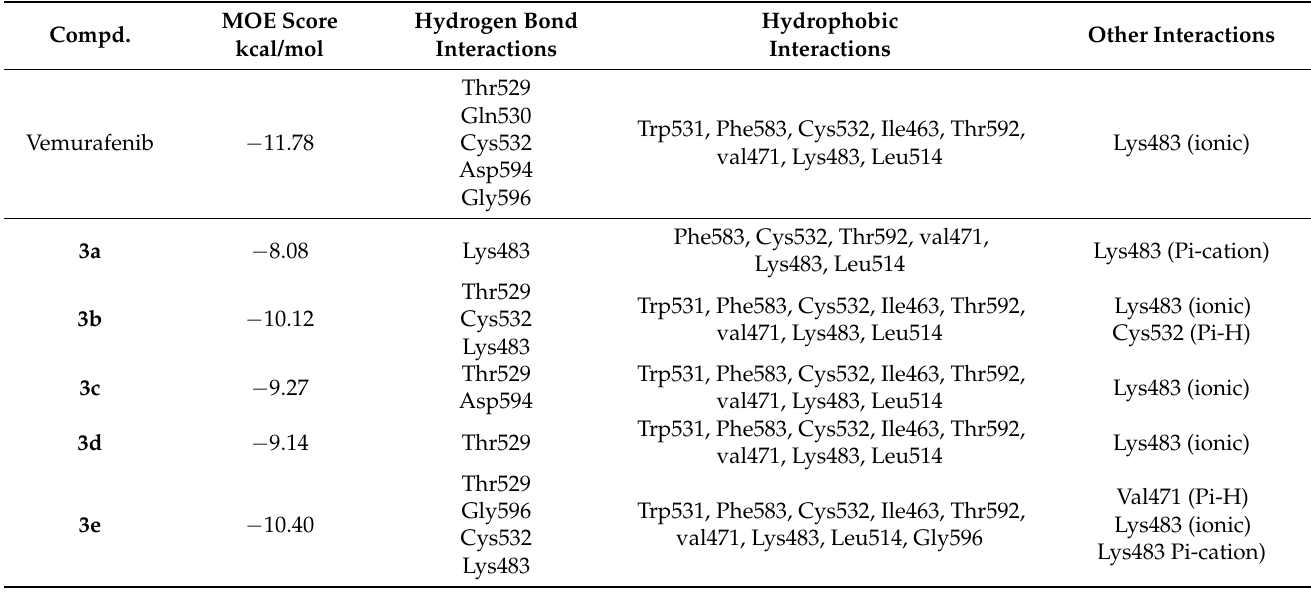
Table 4. Ligand–protein complex interactions of the tested compounds 3a–e within the active site of BRAF V600E